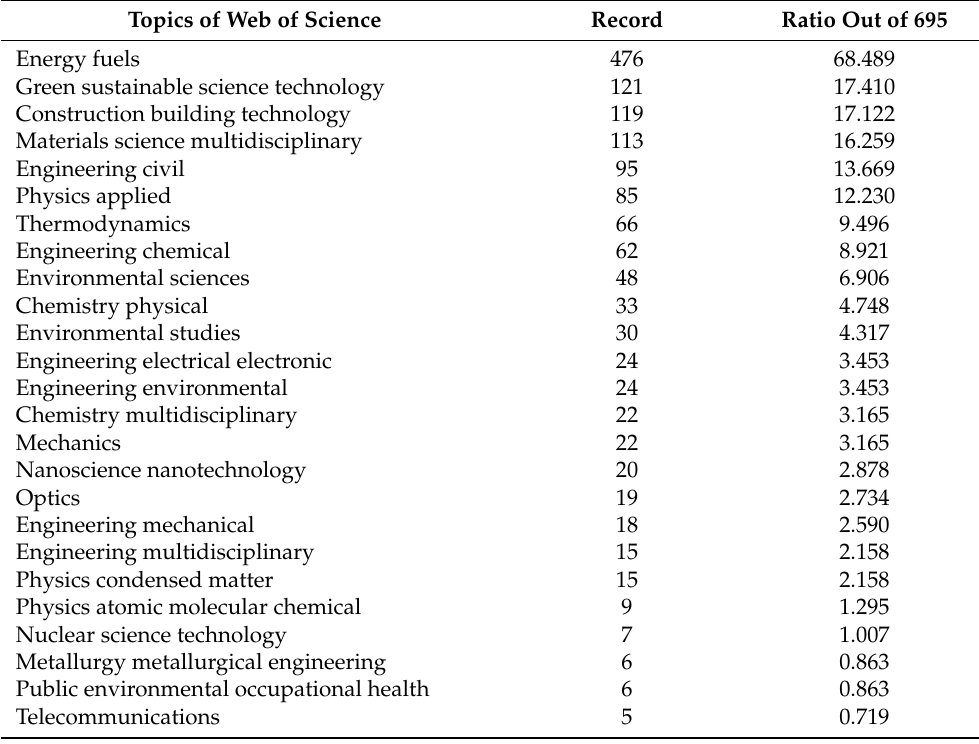
Table 5. The top 58 categories by the “building integrated photovoltaic”